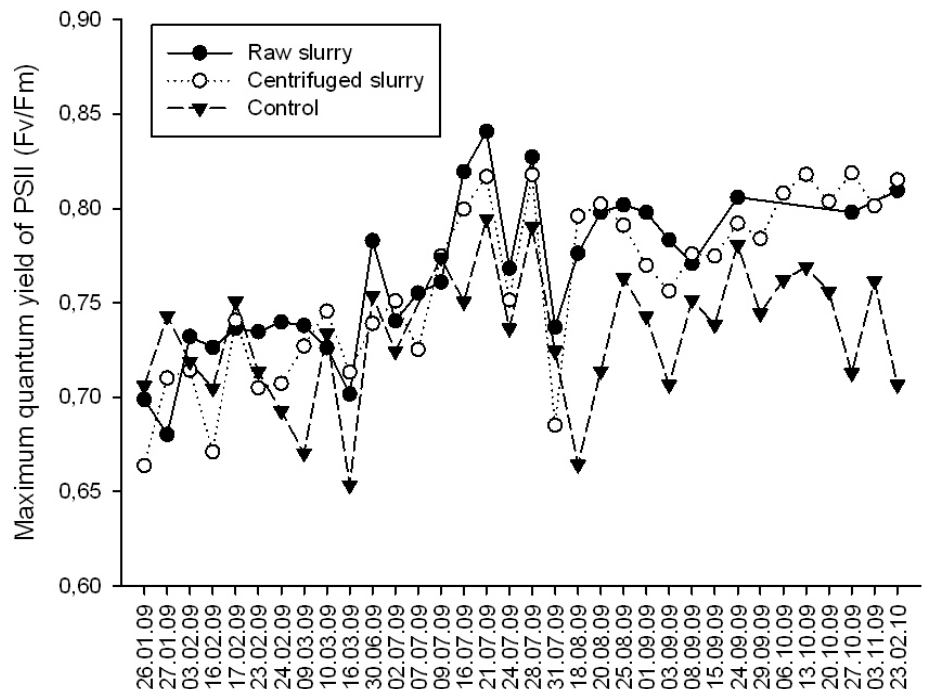
Figure 1. Average values of the maximum quantum yield of the Photosystem II ( Fv / Fm ) of the species Gigantochloa wrayii (GW), Bambusa oldhamii (BO), Bambusa vulgaris (BVV) by treatment plot (January 2009-February 2010 out of the total 2-year experiment: June 2008-June 2010). Chlorophyll fluorescence parameter Fv / Fm , which is the ratio of variable to maximum fluorescence after dark-adaptation, represents maximum quantum yield of PSII. The parameter has begun to be used for detecting stress in plants. In this study, Fv / Fm distribution pattern was analyzed in plants under various stress conditions in order to obtain basic knowledge for identifying the stress factor.